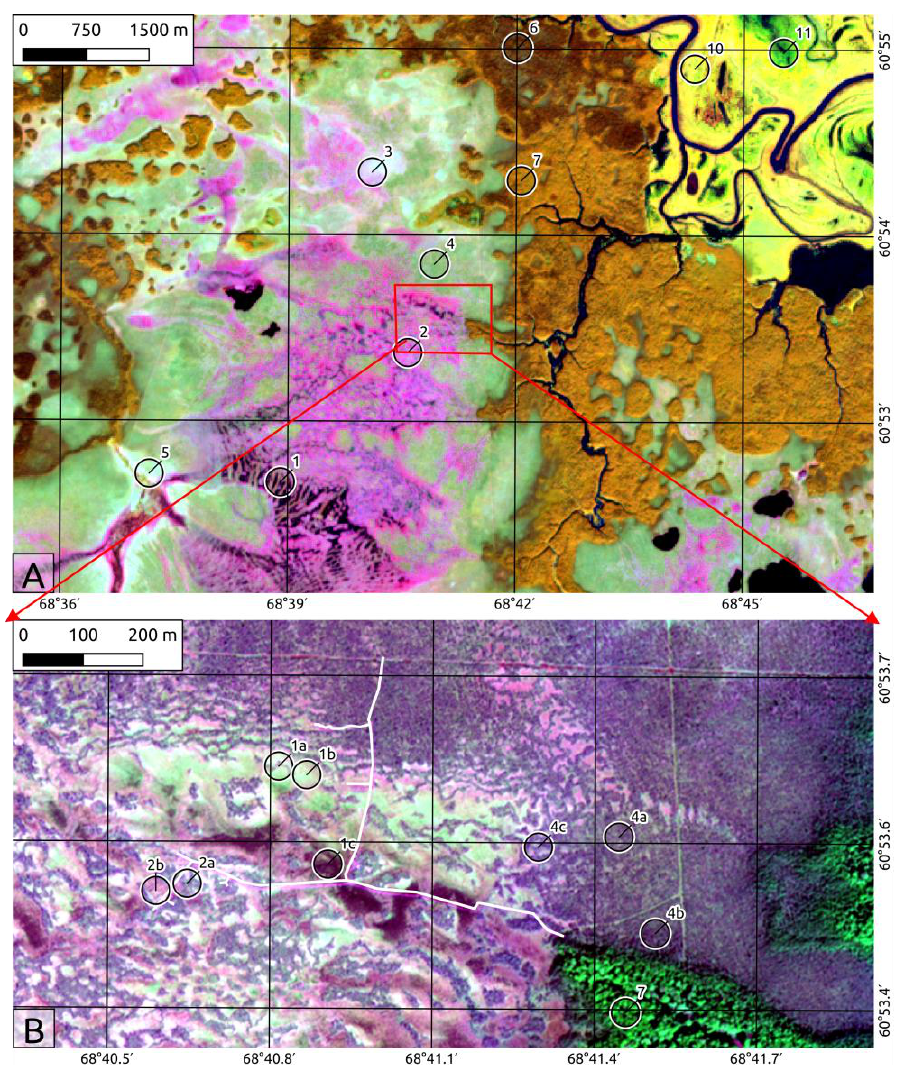
Figure 2. ( A ): Sentinel-2 image with B8(NIR)-B11(SWIR)-B4(RED) false color band combination, 15 m spatial resolution. ( B ): Resurs-P image true color 2 m spatial resolution. 1: Ridge-hollow-pool patterned bogs and water tracks; 1a, Dwarf shrubs- Sphagnum ridges; 1b, Sphagnum lawns; 1c, Water pools and waterlogged hollows. 2: Ridge-hollow patterned bogs; 2a, Pine-dwarf shrubs, Sphagnum ridges; 2b, Sphagnum hollows. 3: Dwarf shrub Sphagnum bog with sparse low pine trees (‘Open bog’). 4: Wooded pine-dwarf shrub- Sphagnum bog (Ryam); 4a, Typical ryam; 4b, Tall ryam; 4c, Ryam with small cotton grass hollows. 5: Sedge- Sphagnum fen (incl. sparse low birch fens). 6: Dark coniferous and mixed forest. 7: Small-leaved forest. 8 and 9: Floodplain willow and meadows. 10: Floodplain sedge wetlands.